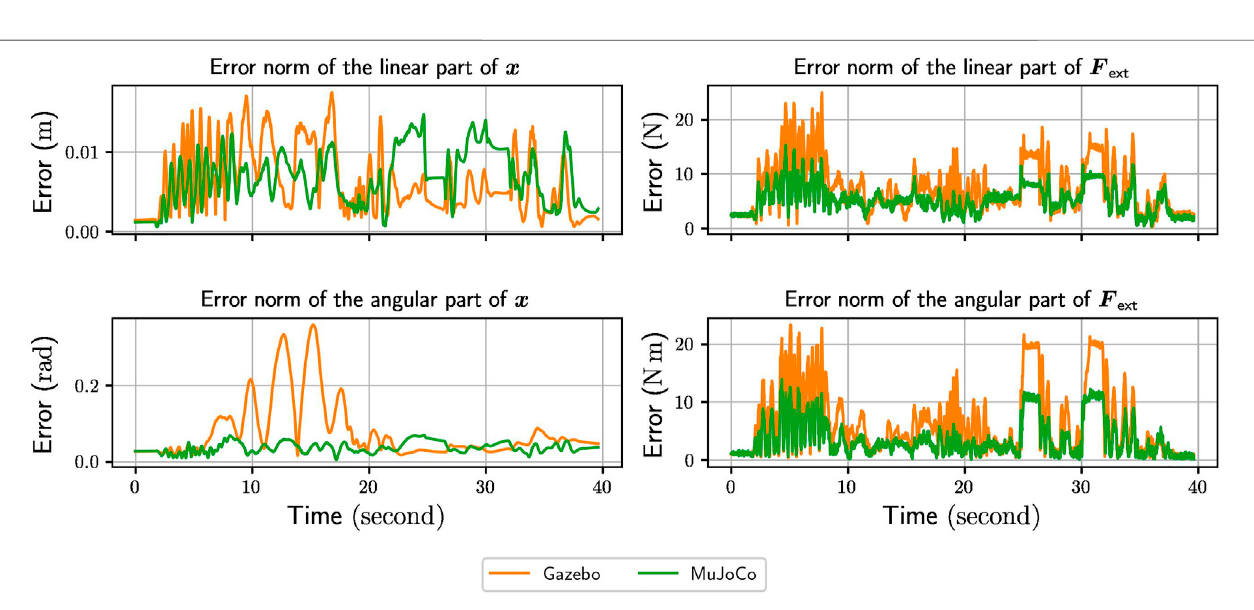
Frontiers in Virtual Reality |